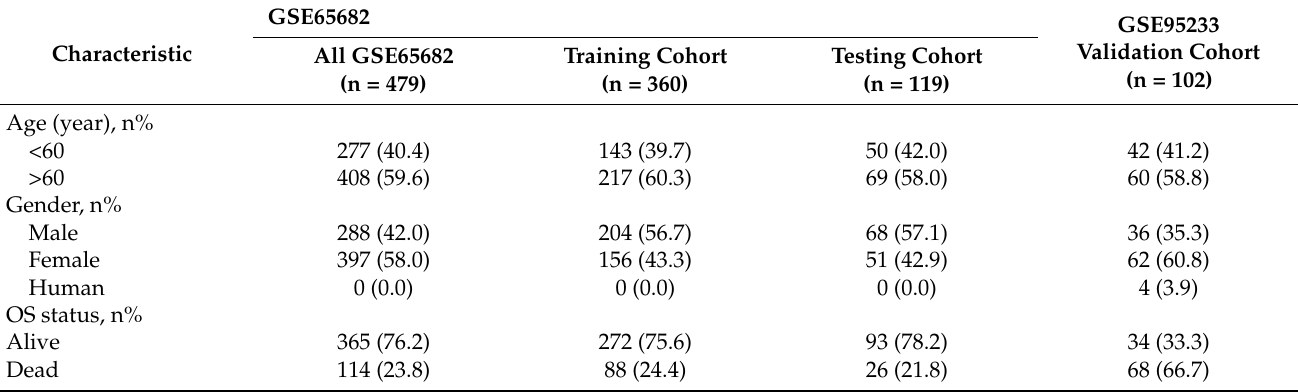
Table 1. Clinicopathological characteristics of the sepsis cases in GSE65682 and